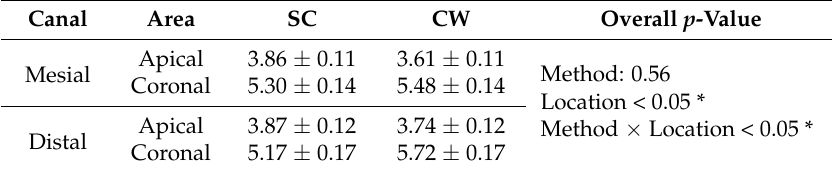
Table 1. The percentage of voids between the filling material and the root canal wall (V out ).